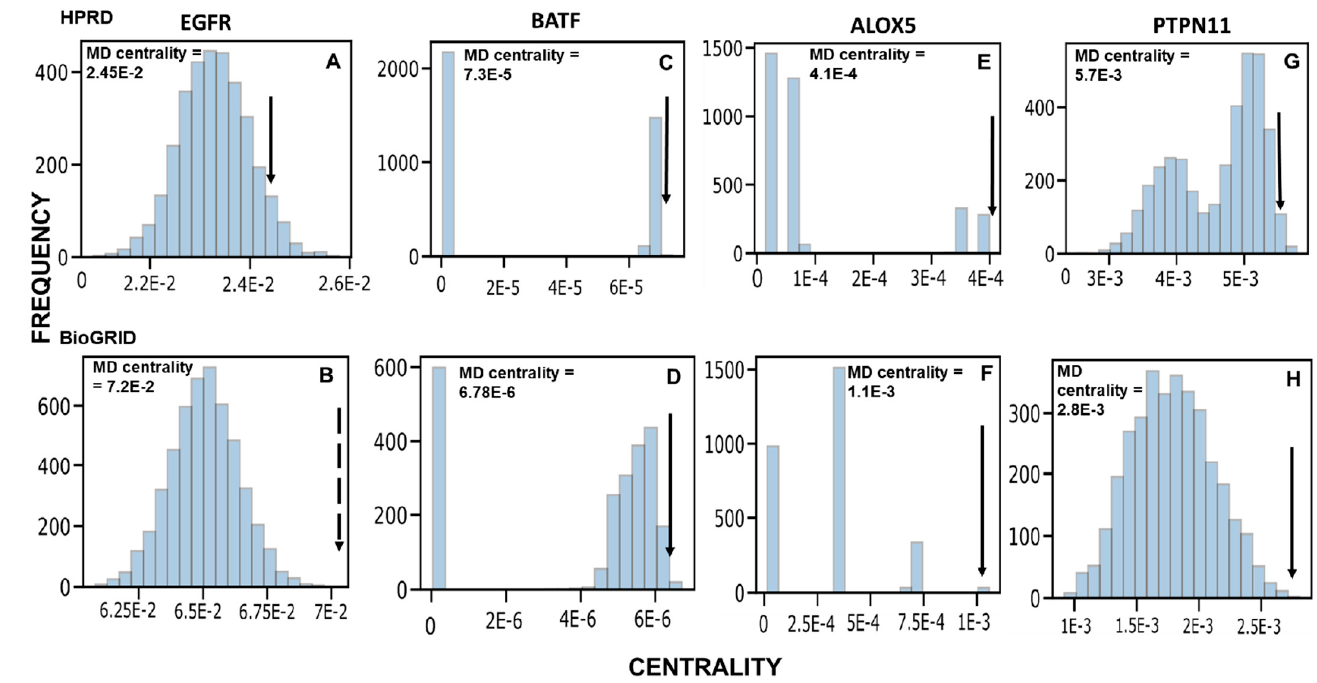
Figure 3. Centrality distributions of some genes in HPRD (top) and BioGRID (bottom); ( A , B ): EGFR; ( C , D ); BATF; ( E , F ): ALOX5; ( G , H ): PTPN11. MD centrality scores are the betweenness centrality values of these genes in the MD network. The black arrows indicate the MD centralities for the genes. All of the genes are significant in both the PPI networks (based on raw p values). For these genes, their centrality scores in random networks are rarely higher than their corresponding centrality in the MD network and hence have low p values.